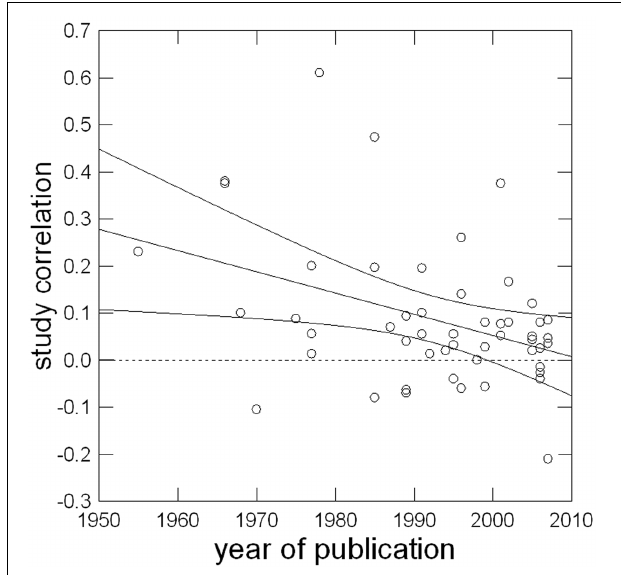
FIGURE 3 | Linear relationship of year of publication with study correlation corrected for sampling error.